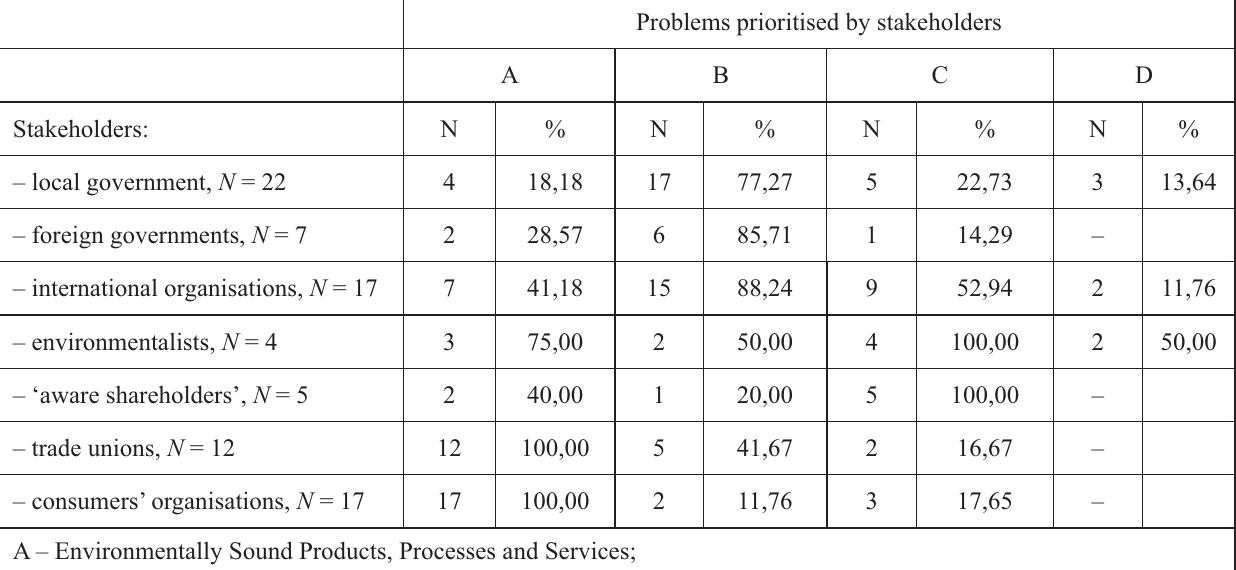
Table 2. Stakeholders’ sensitiveness to environmental issues (frequency in count and %) Problems prioritised by stakeholders